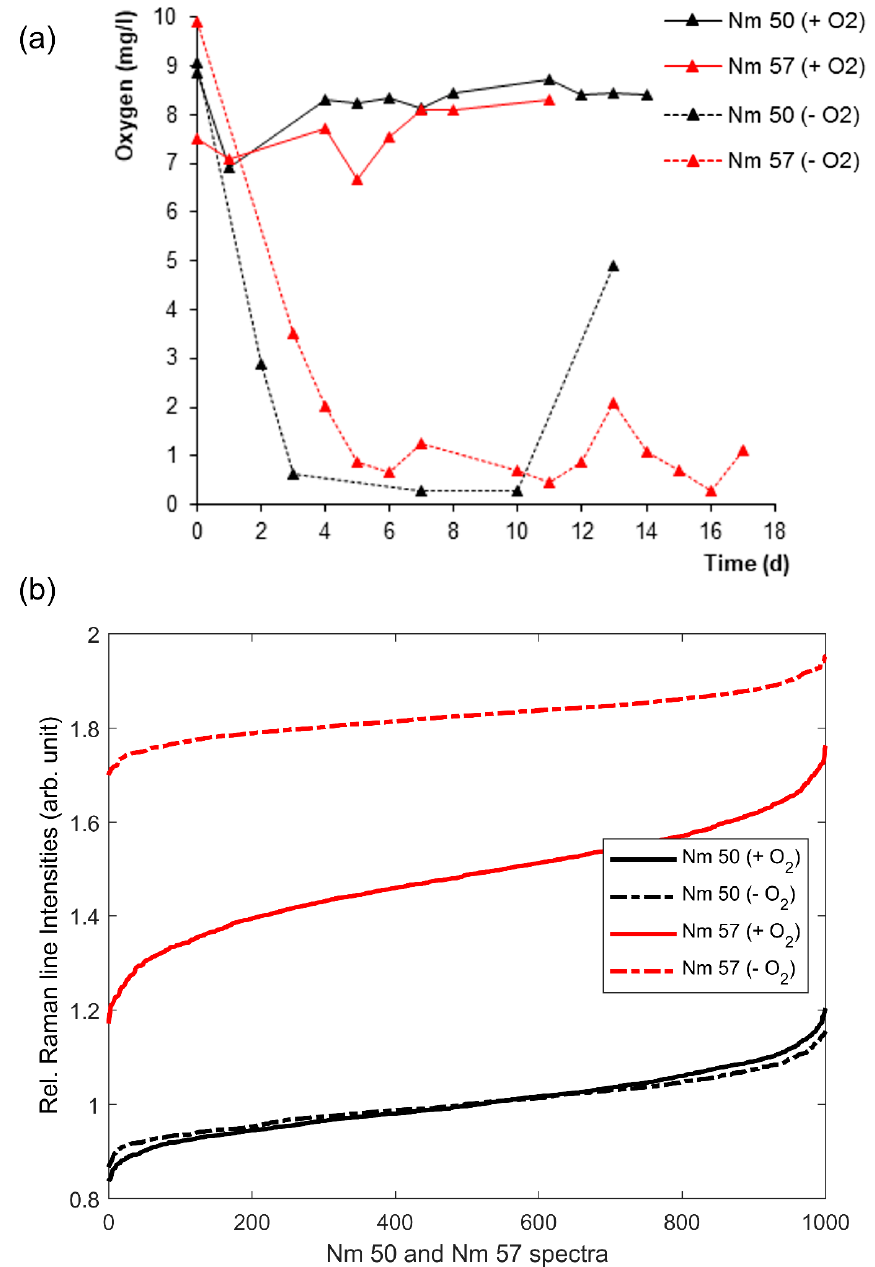
Figure 3. Oxygenation history ( a ) and relative Raman line intensities (relRI) sorted in ascending order of 1000 random cells each ( b ) of Nitrosomonas europaea (Nm 50) (black) and Nitrosomonas eutropha (Nm 57) (red) grown under well-aerated (solid) or oxygen-deprived (dashed) conditions.